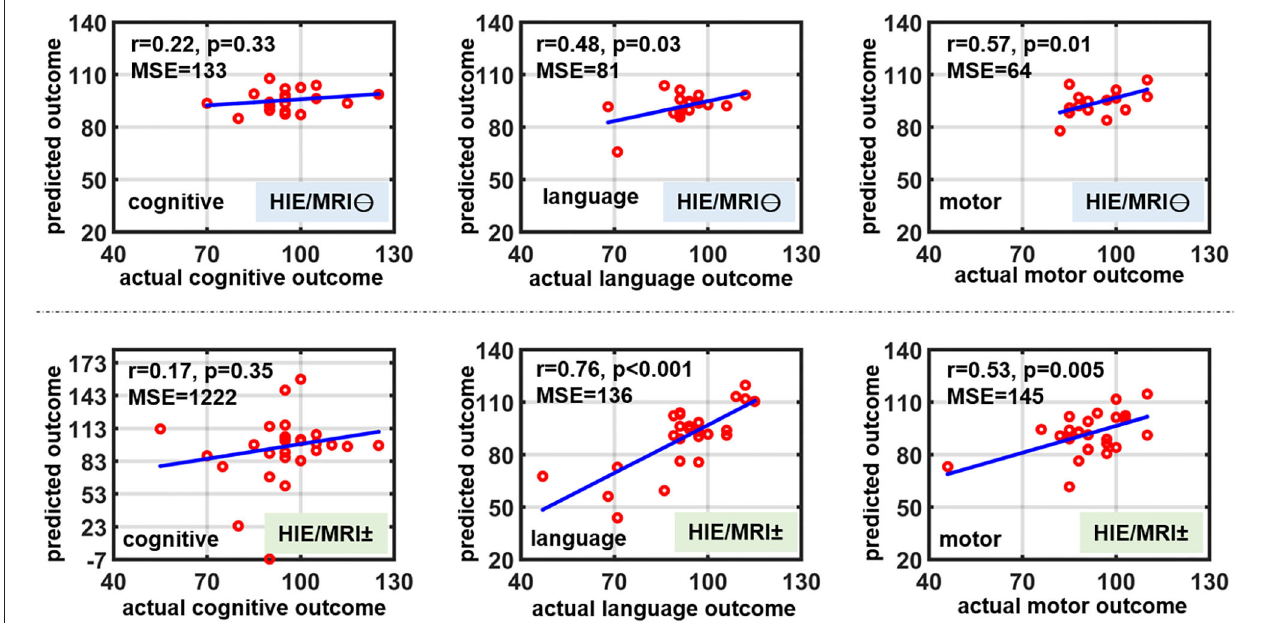
FIGURE 2 | Outcome prediction performance in HIE/MRI ⊖ group (first line) and HIE/MRI ± group (second line). In the both groups, the predicted outcomes by machine learning model are significantly correlated with language and motor outcomes, but not with cognitive